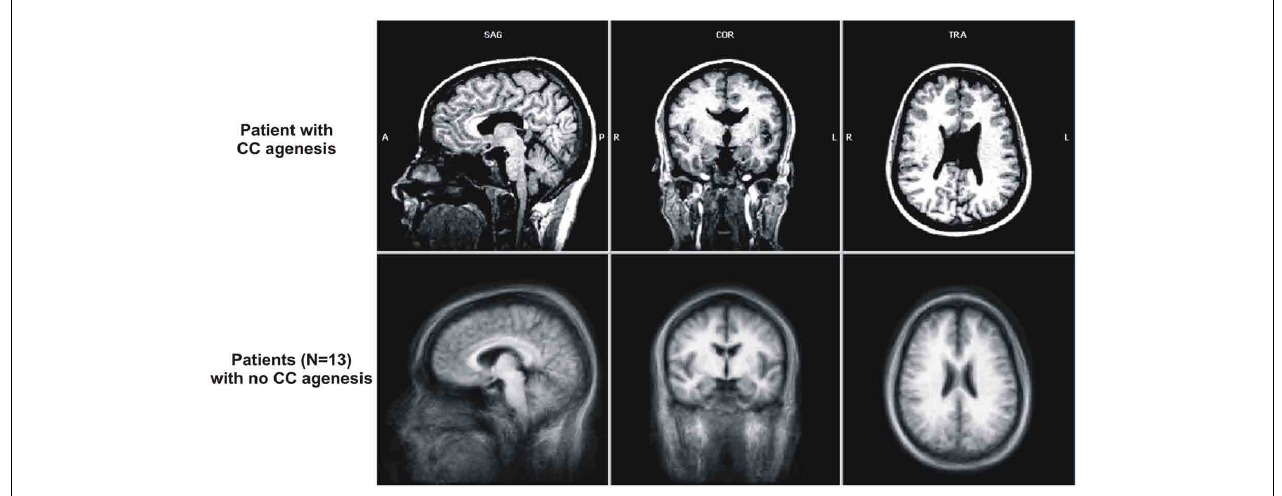
FIGURE 1 |The anatomical images for the schizophrenia patient with corpus callosum (CC) agenesis (top) and the average anatomical images for the 13 schizophrenia patients with no apparent CC agenesis. All images are normalized toTalairach space and the coordinates areTalairach coordinates.